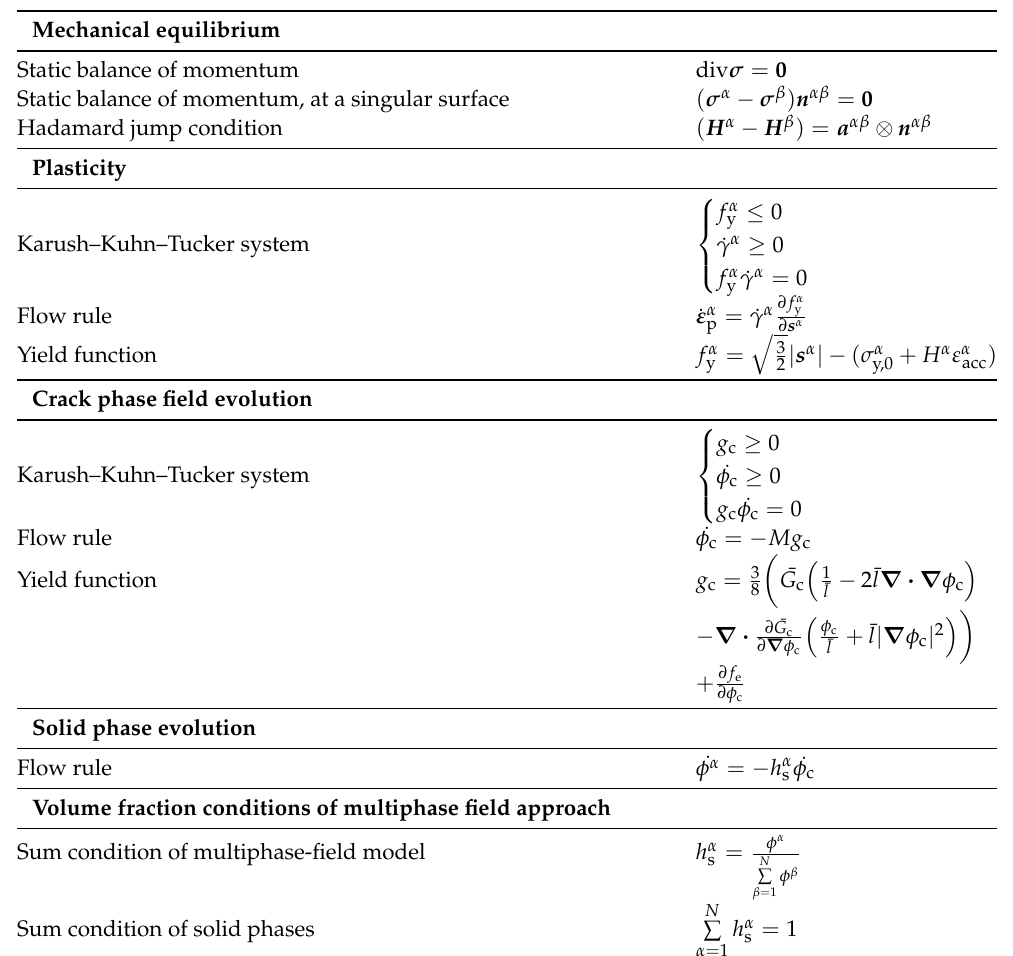
Table 1. Governing equations of the phase-field crack model.